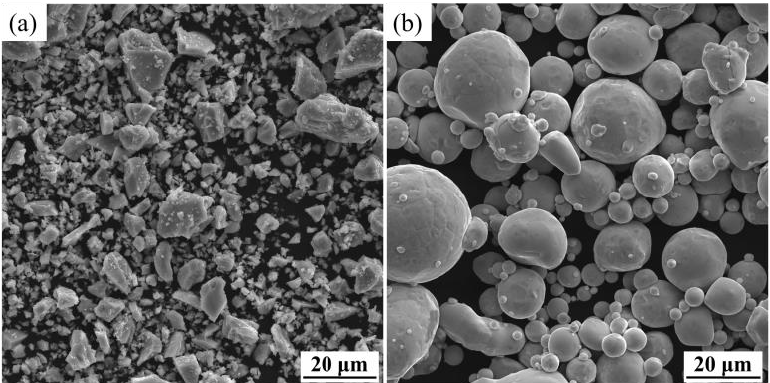
Figure 1. SEM images of raw powders: ( a ) HDH Ti; ( b ) Ni. Table 1. The reagents of the gel system used.